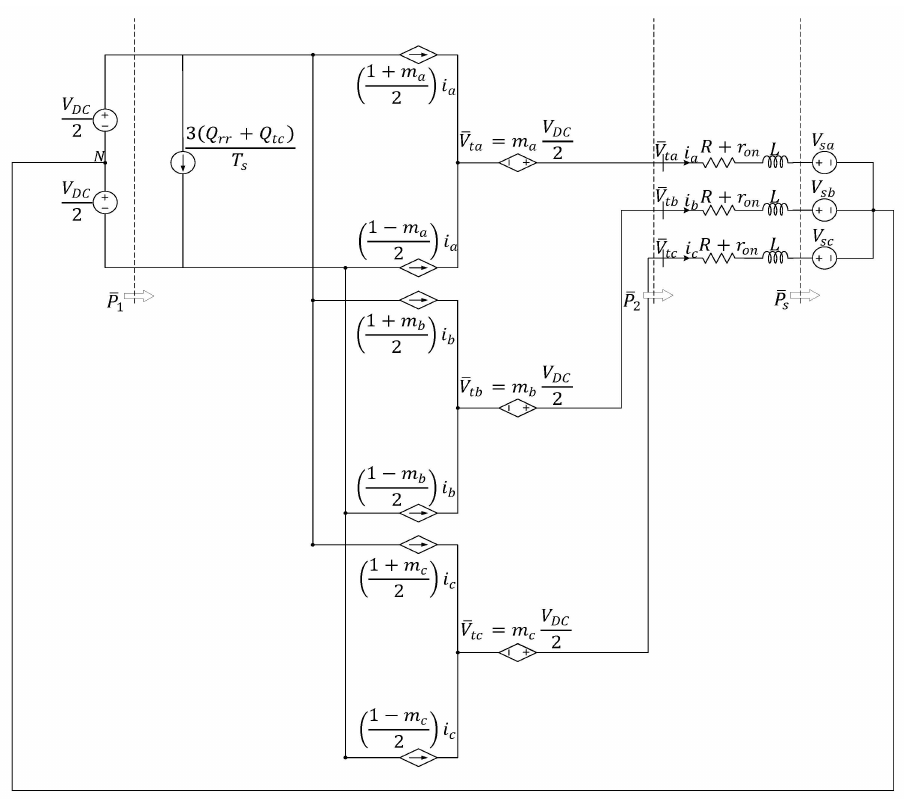
Figure 18. Nonideal 2-level converter average equivalent circuit. Based on the average power loss equation of the 3-phase 2-level converter shown in Equation (9), the MATLAB/SIMULINK model was implemented as shown in Figure